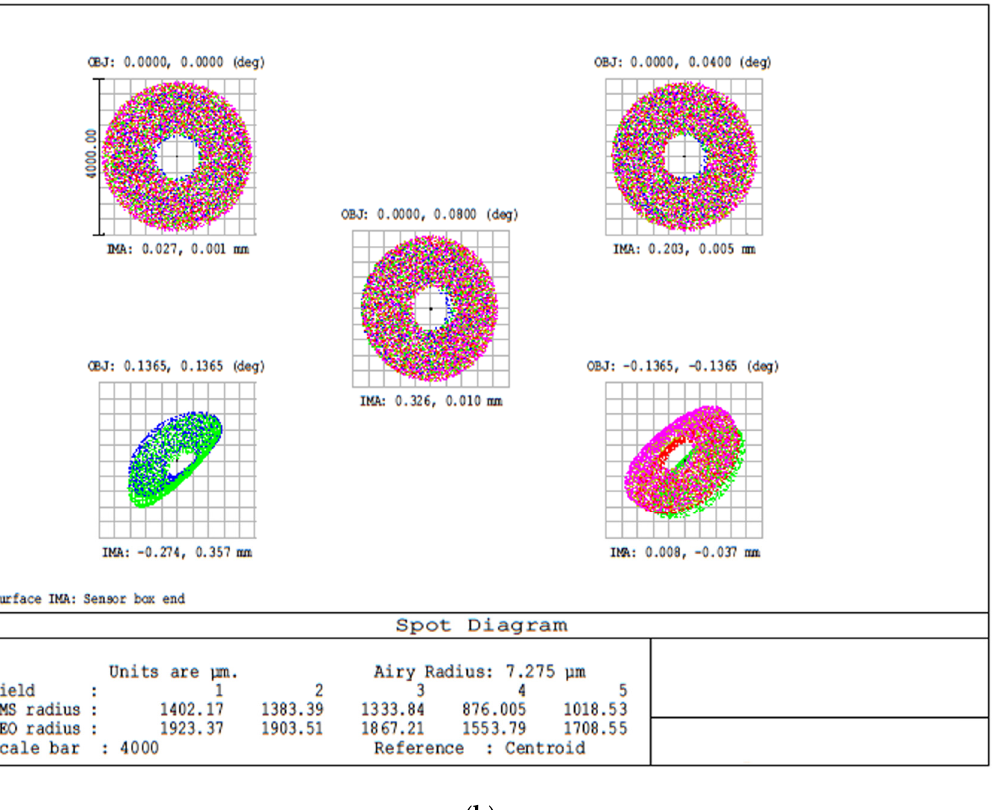
Figure 5. Optical design of the CS instrument: ( a ) spectrum on the image plane (DMD surface) for different angles in the instrument field of view and ( b ) spot radius on the PMT. The PMT is placed where the focused beam diameter is minimal, providing both spot minimization and image mixing on the detector area. The beam at the detector plane is defocused so that the figure shows the corresponding pupil obscuration.